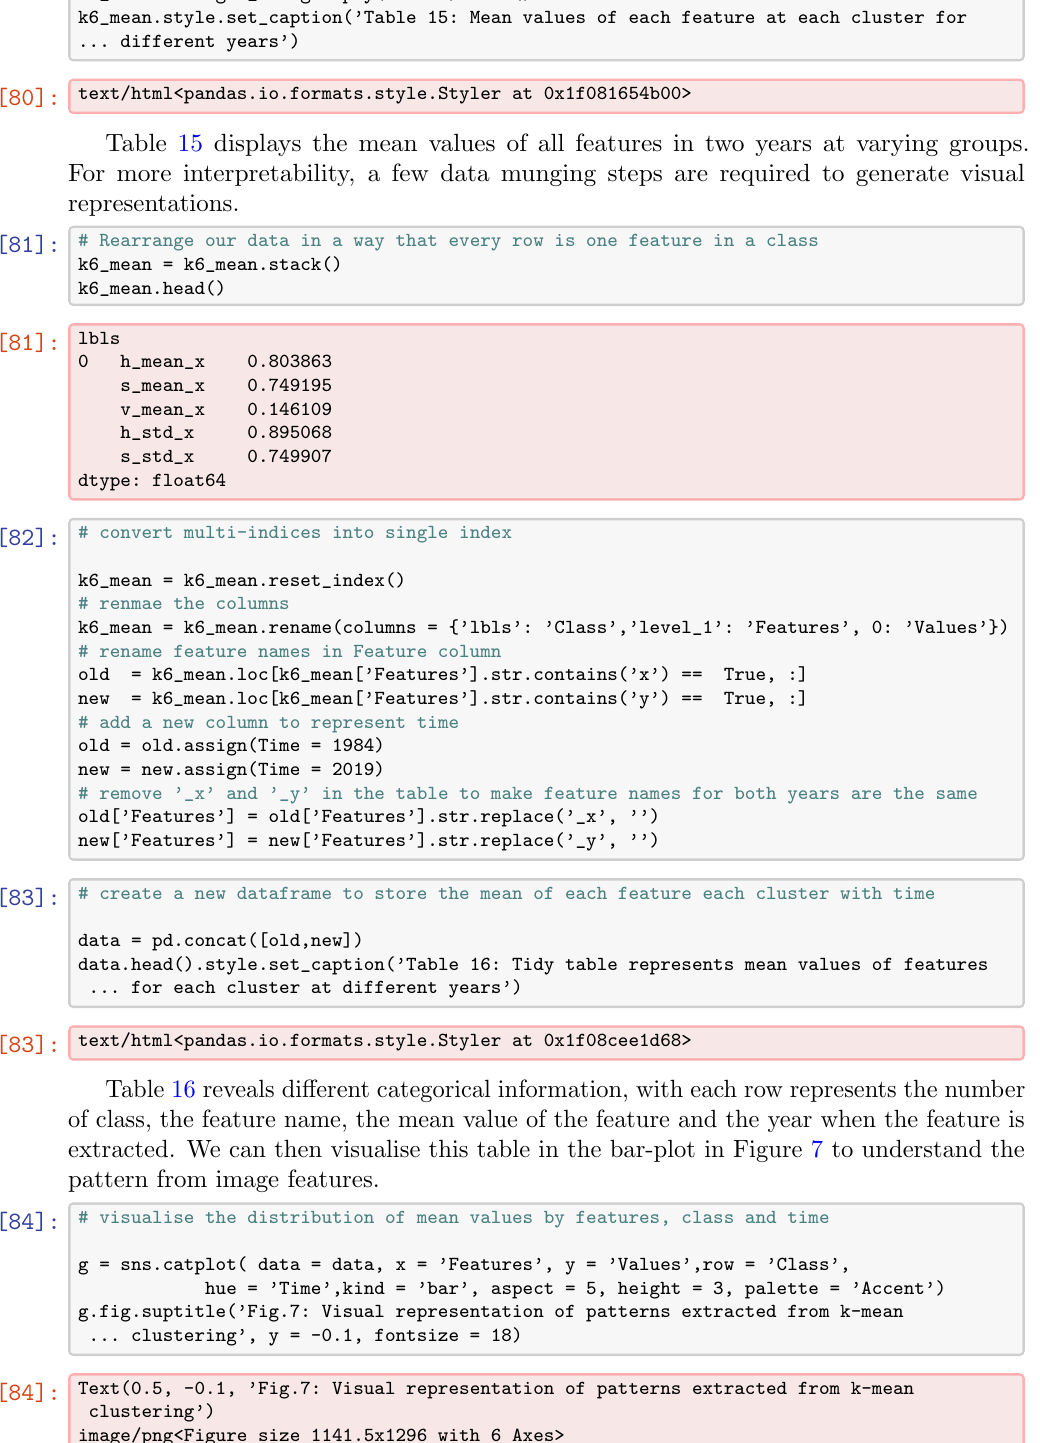
g.fig.suptitle(’Fig.7: Visual representation of patterns extracted from k-mean ... clustering’, y = -0.1, fontsize =